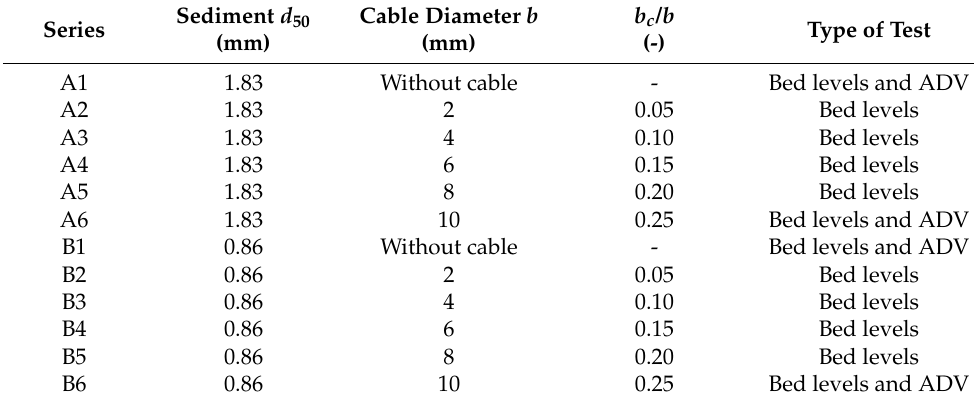
Table 1. Summary of experimental conditions where b c /b is the cable diameter/pier diameter ratio, where the cylinder diameter b = 40 mm and cable diameters were 2, 4, 6, 8, and 10 mm. Tests were conducted with flow depth y = 70 mm, discharge Q = 7.5 Ls − 1 , and pier-based Reynolds number ( Re= u.b/ ν ) of 7120. The type of test indicates the series for which bed levels and ADV velocity measurements were